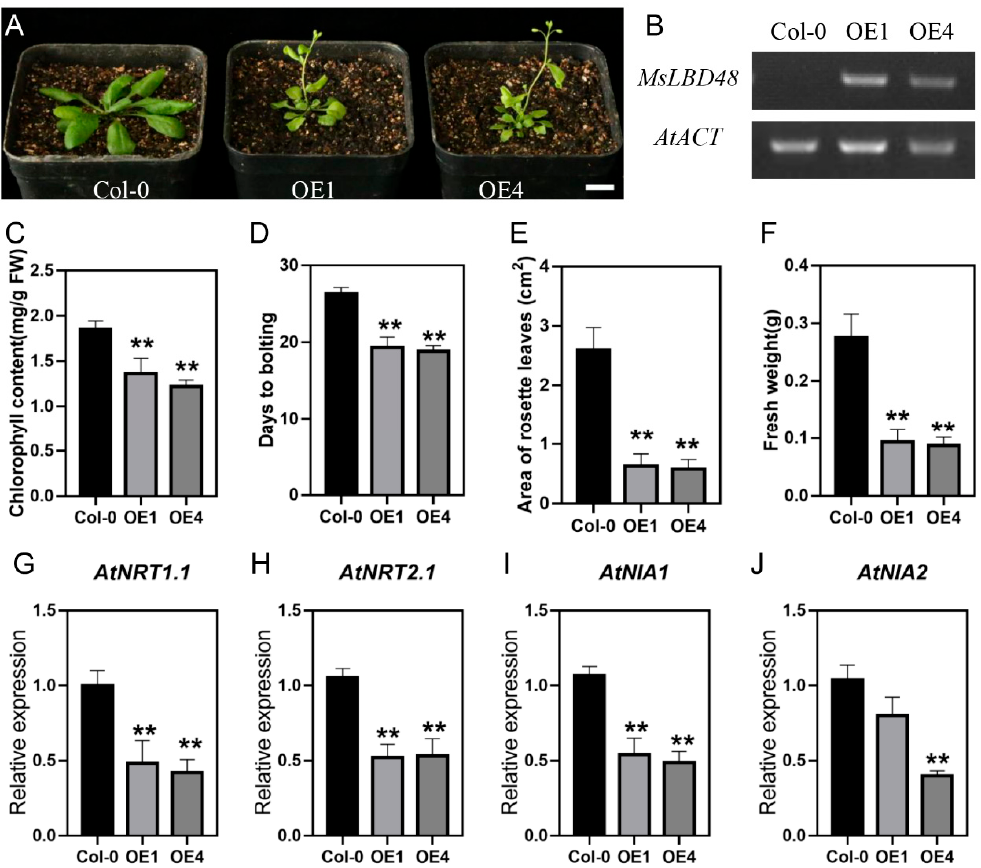
Figure 9. The MsLBD48 gene is involved in the regulation of nitrogen uptake and assimilation-related gene expressions and affects N dependent status. ( A ) Image of the 19-day-old plants grown under LD. Bar = 2 cm. ( B ) RT-PCR detected the expression of MsLBD48 in two Arabidopsis overexpression lines. ( C – F ) Phenotype of the MsLBD48 overexpression lines. ( G – J ) The expression level analysis of key nitrate uptake and assimilation-related genes by qRT-PCR. Bars represent the ±SD of three biological replicates. The ** indicates p < 0.01 (Student’s t-test).